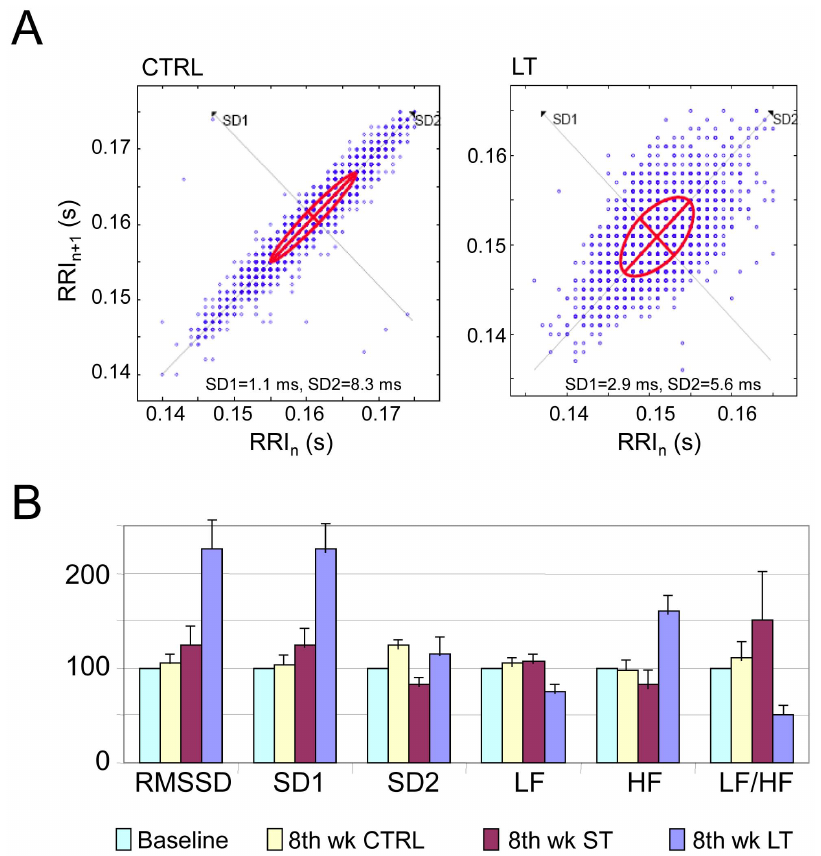
Figure 1. Heart rate variability measures. A. Poincare plots for sample CTRL and LT animals (comparison of ST group to CTRL was not significant, not shown). B. HRV parameters for the 3 groups relative to their normalized value at week 1 in %.